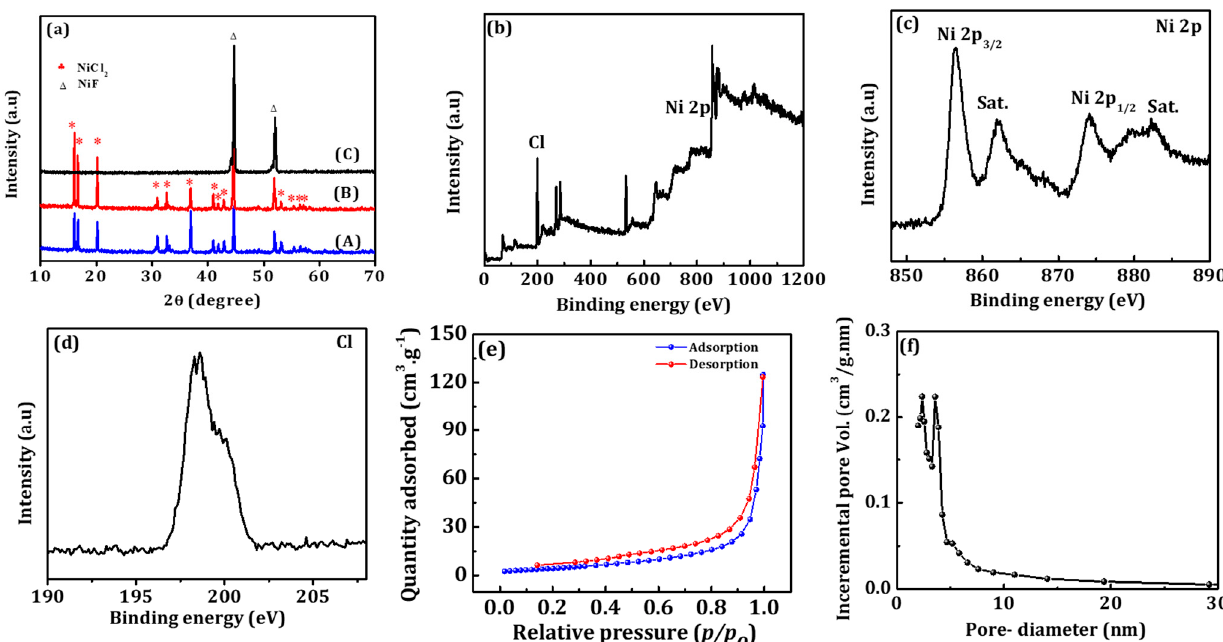
Figure 2. ( a ) XRD patterns (A and B) electrode with and without glycerol NiCl 2 and C (i.e., NiF), ( b ) full XPS spectrum survey, ( c ) Ni 2p, ( d ) Cl, ( e ) BET and ( f ) pore size distribution of electrode with glycerol, respectively.